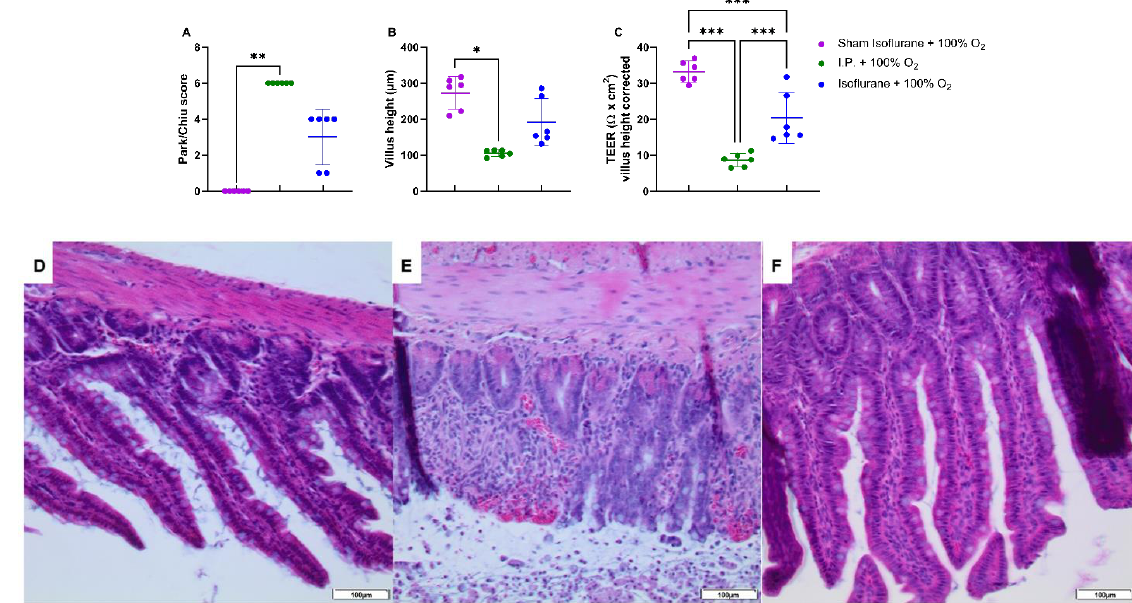
Figure 6. Intestinal epithelial injury was assessed by Park – Chiu score ( A ) and villus height ( B ). Histopathological pictures after hematoxylin – eosin staining are shown in ( D – F ): ( D ): Sham isoflurane + 100% O 2 ; ( E ): I.P. + 100% O 2 ; ( F ): isoflurane + 100% O 2 . Intestinal epithelial permeability was measured by TEER in an Ussing chamber setup, which was corrected for the villus height ( C ). ( n = 6/group). I.P.: intraperitoneal injection anesthesia; O 2 : oxygen; TEER: transepithelial electrical resistance. * p < 0.05; ** p < 0.01; *** p < 0.001.